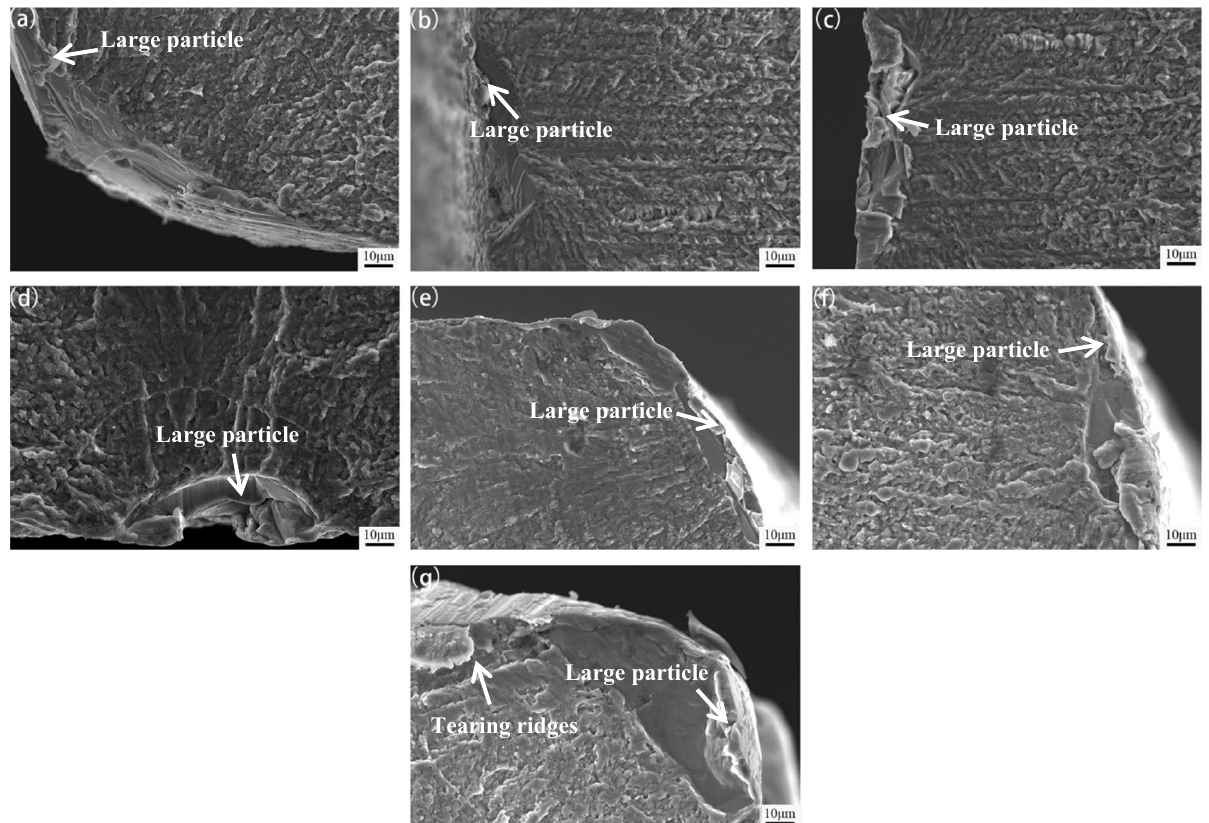
Figure 9. Scanning electron microscopy (SEM) images of fatigue fracture initiation in 7005 aluminum alloy plates aged at 120 °C for different durations: ( a ) 1 h, ( b ) 4 h, ( c ) 8 h, ( d ) 12 h, ( e ) 24 h, ( f ) 96 h, and ( g ) 192 h.